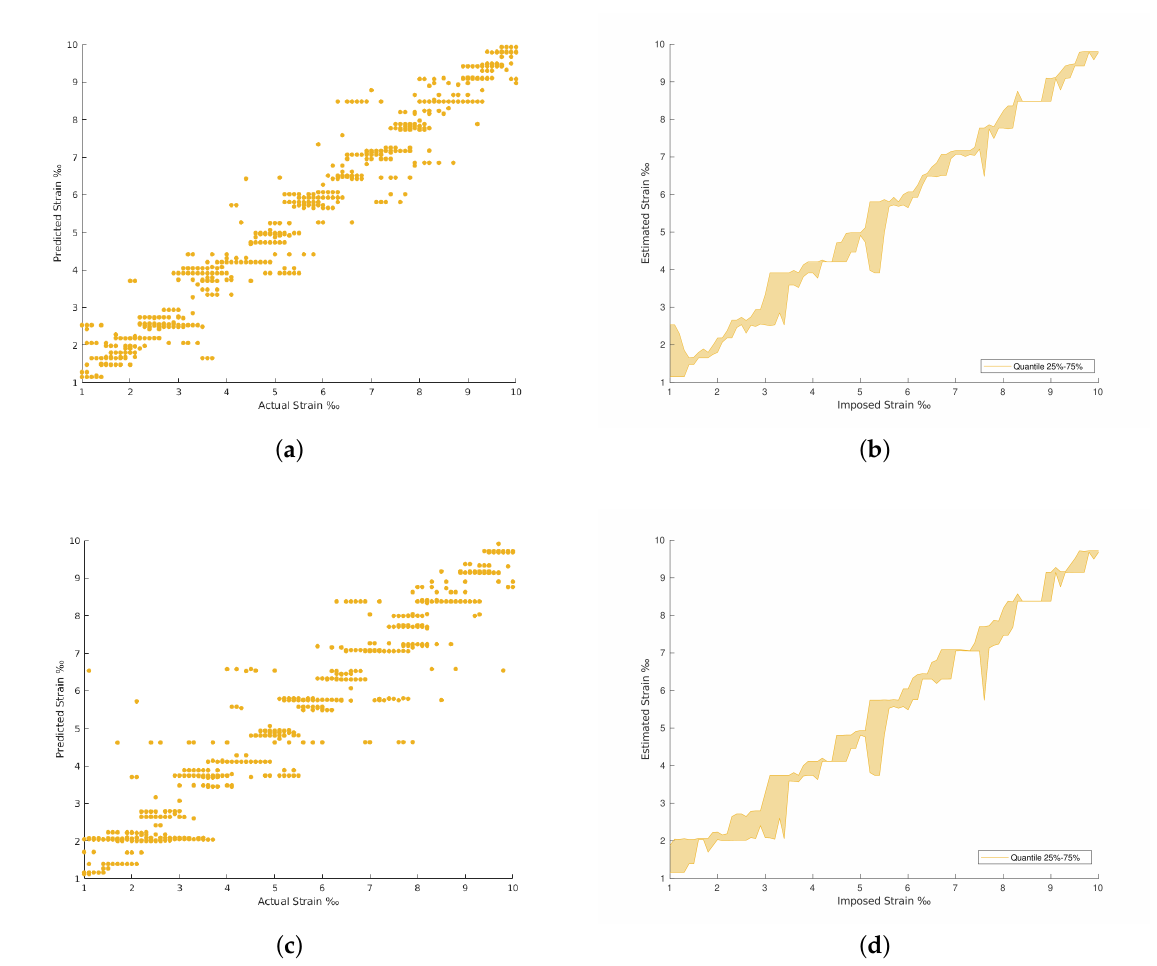
Figure 10. Fully connected neural network (FCNN) and Random Forest results. ( a ) Random Forest Regression predictions. ( b ) Random Forest Regression predictions by quantile variations. ( c ) FCNN with regression predictions. ( d ) FCNN with regression predictions by quantile variations.